Question: According to the figure, is the described quantity increasing or decreasing?
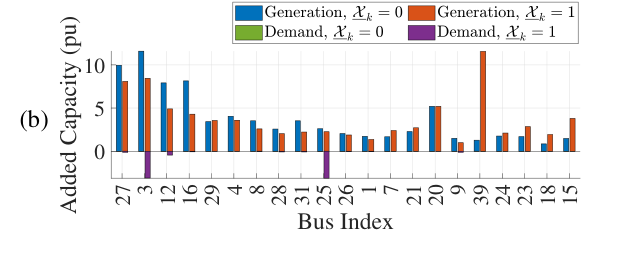
Answer: increasing